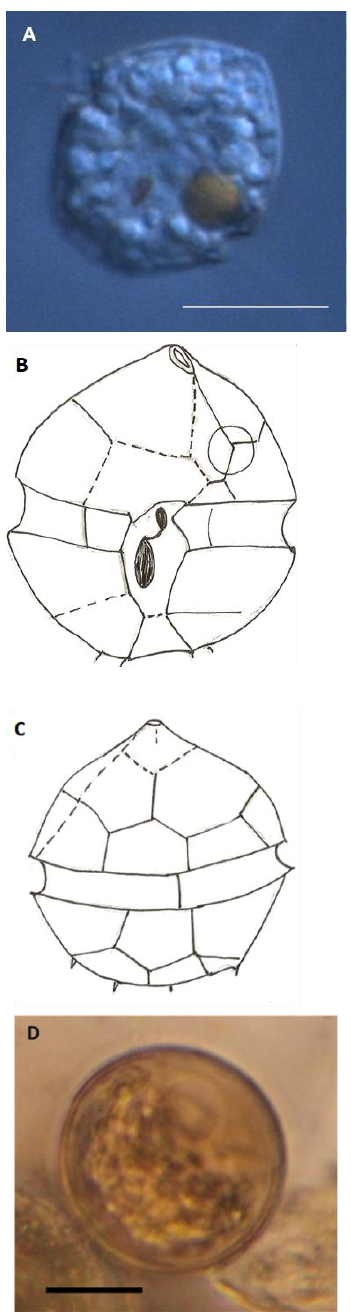
Figure 8. Kryptoperidinium sp. ( A ) The dorsoventrally compressed cell was colorless apart from a characteristic bright-red eyespot. A large vacuole, shifting in placement, often had red-brown contents. ( B , C ) Suggested plate pattern from Calcofluor-colored cells. Broken lines are uncertain; the very small spikes were often more than four and placed in a half-circle. ( D ) The smooth gray cyst was common (possibly Kryptoperidinium sp.?) The scale bar is 10 µm.